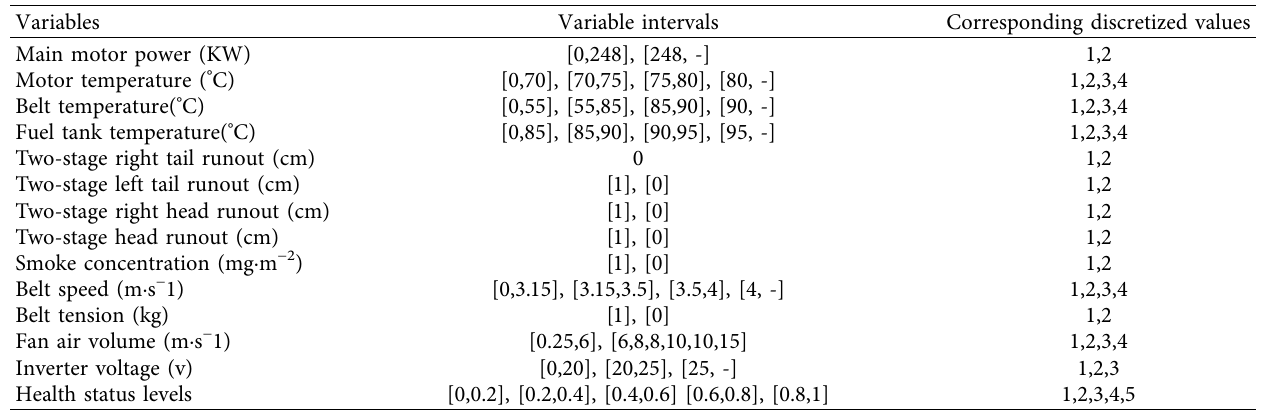
Table 2: Variable interval discretization